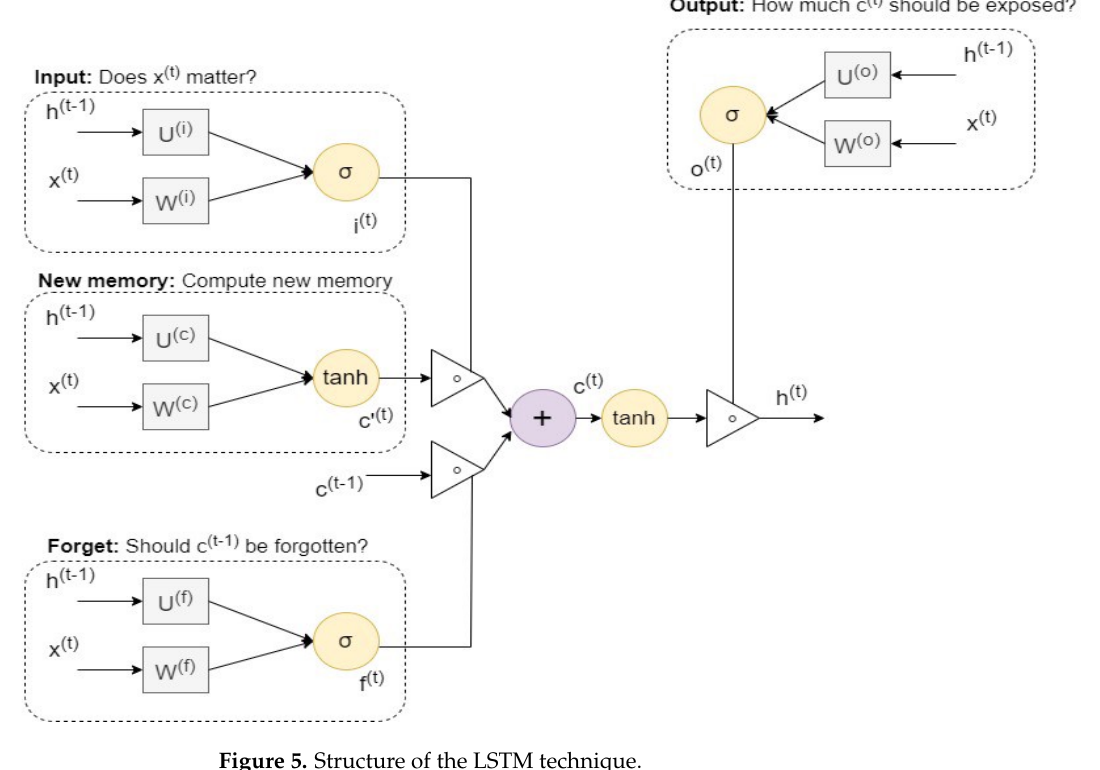
Figure 5. Structure of the LSTM technique.